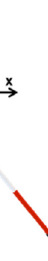
Figure 6. Cane posture in three-dimensional space.